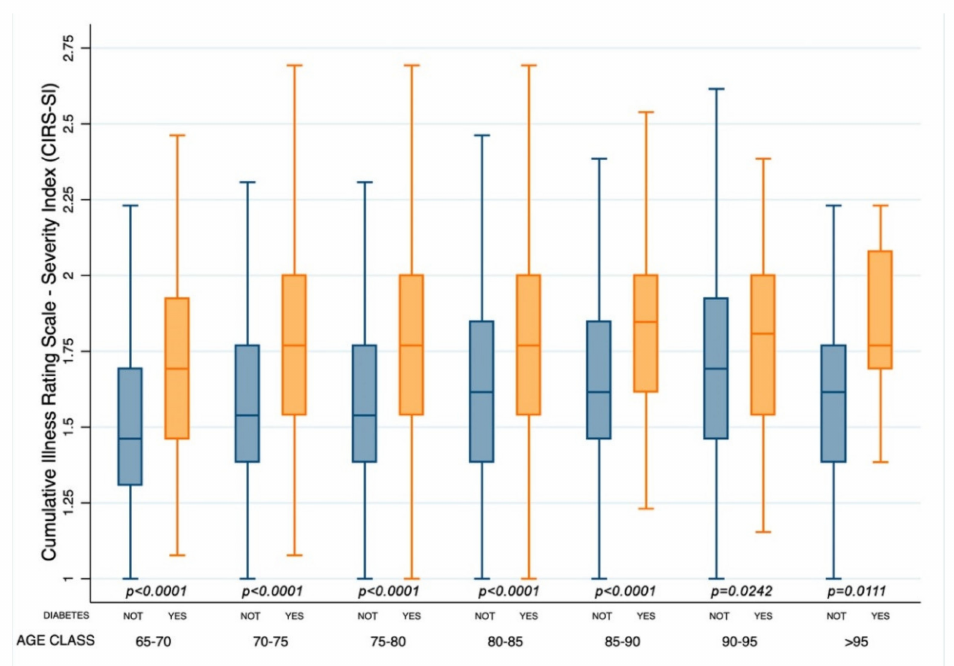
Figure 1. Box and whisker plot of the Cumulative Illness Rating Scale Severity Index [CIRS-SI] according to age classes in patients with or without diabetes (Yes or